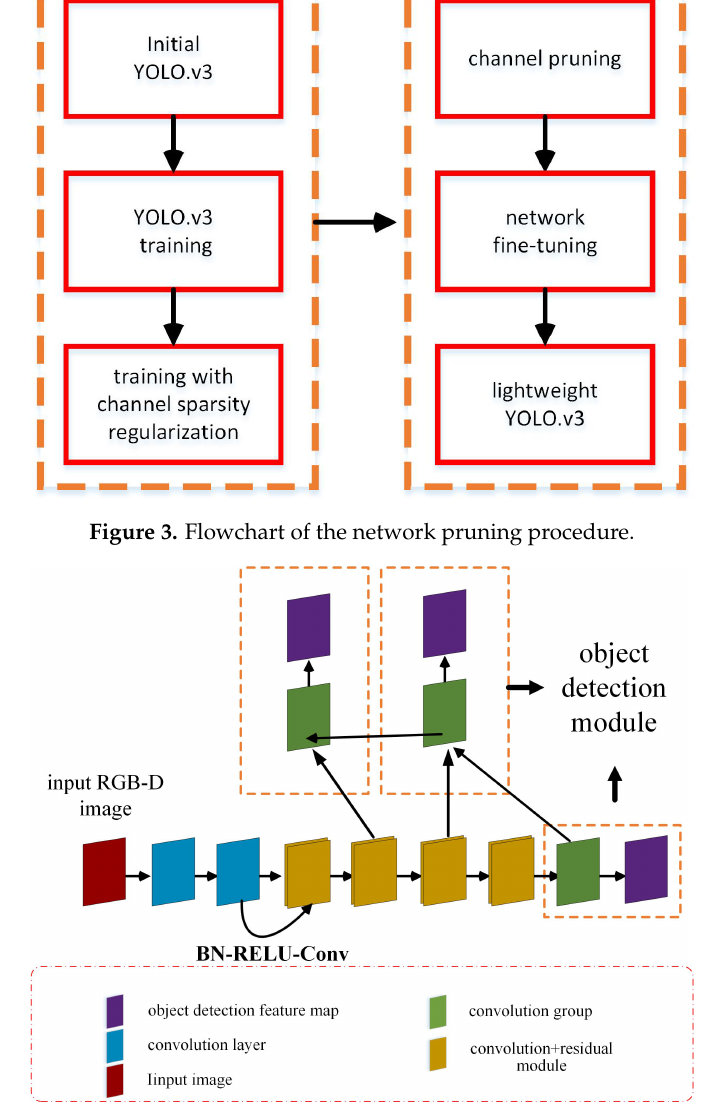
Figure 4. Structure of the lightweight detection network. Table 1. Size of the feature maps and bounding